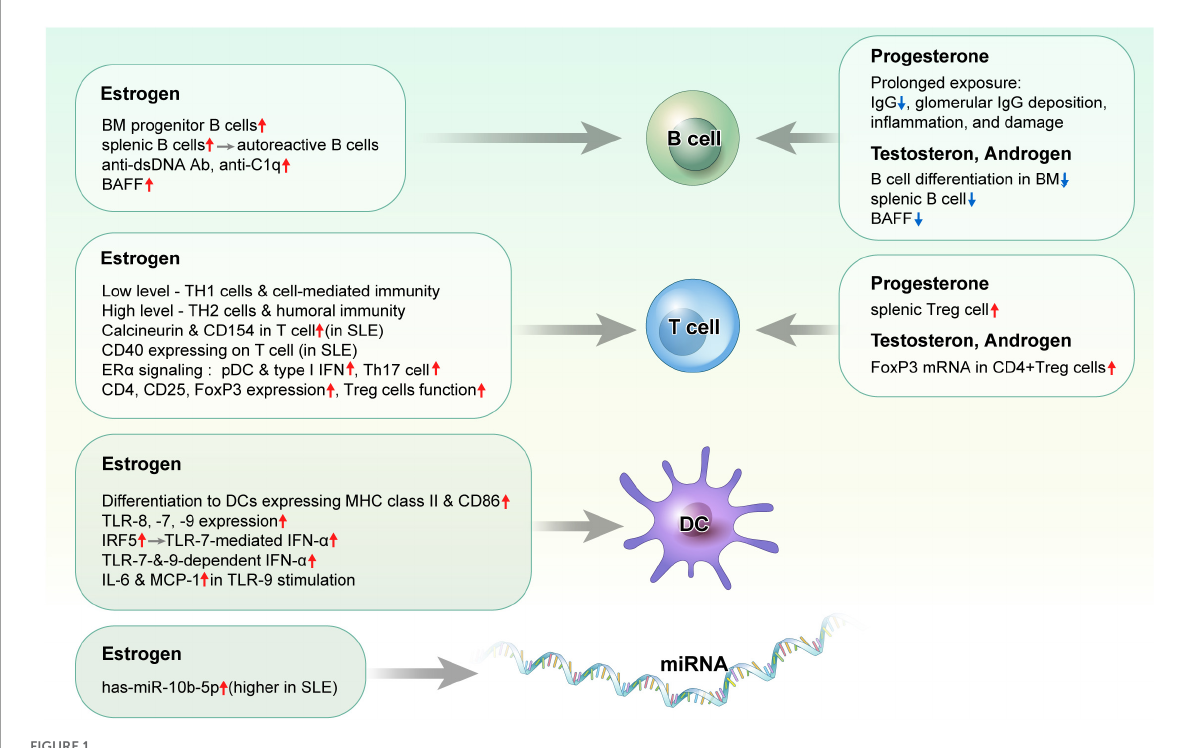
FIGURE1 Effects of sex hormones on immune cells in systemic lupus erythematosus.